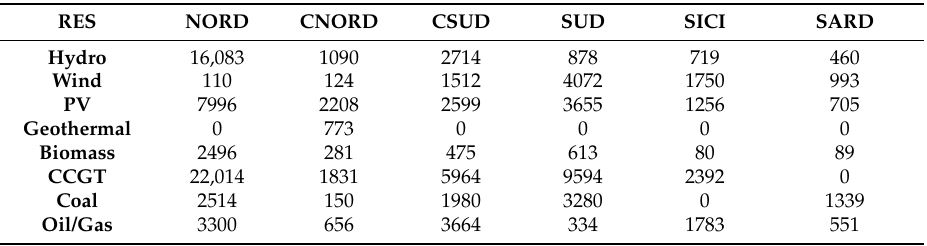
Table 1. Installed capacity (MW) as of